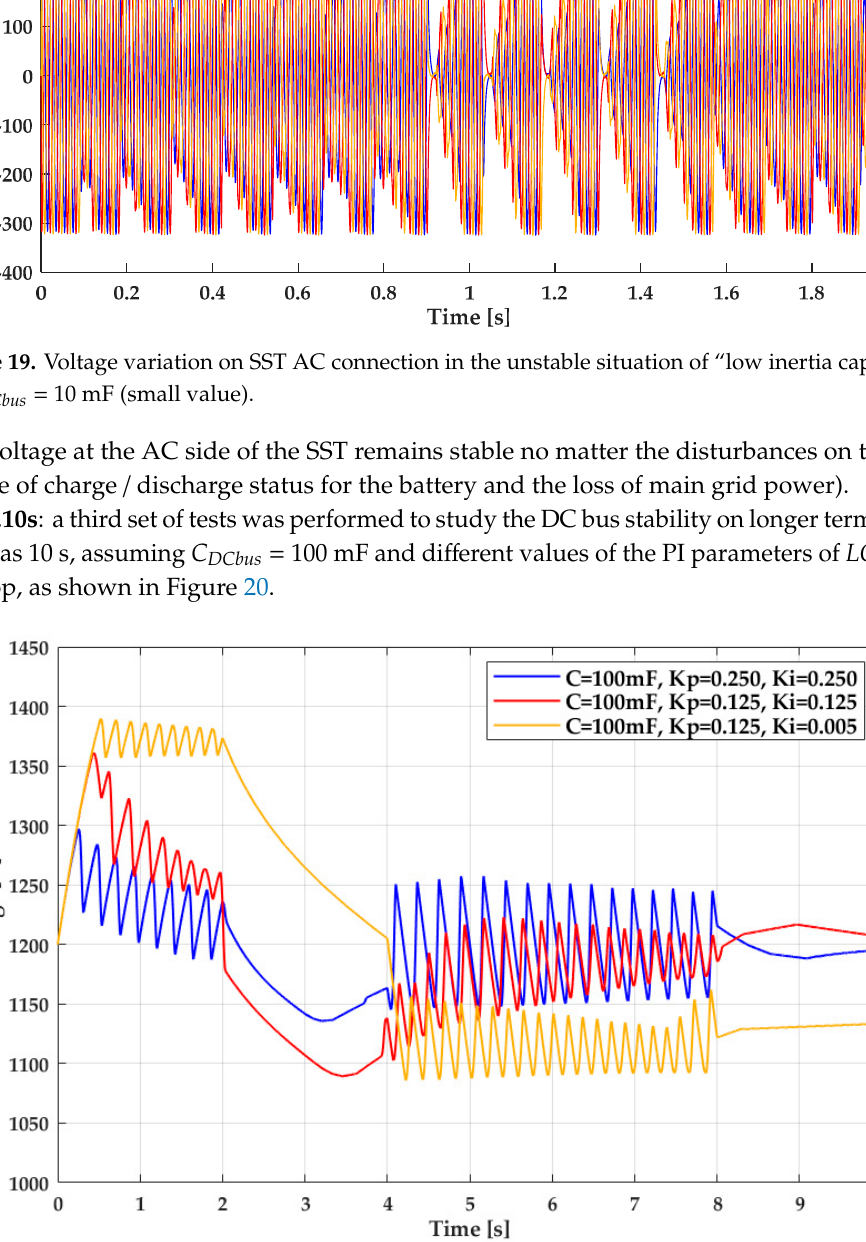
Figure 20. DC bus voltage on longer term control (Scenario 3, with time extended to 10 seconds).